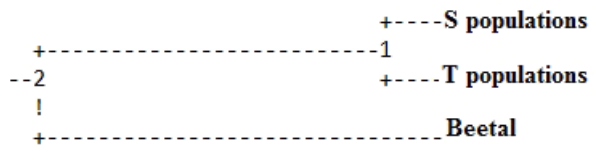
Figure 3. The phylogenetic dendrogram showing the genetic re- lationships between the Beetal breed and the S and T populations of the other breeds studied using the Nei (1978) standard genetic distance obtained from five ISSR